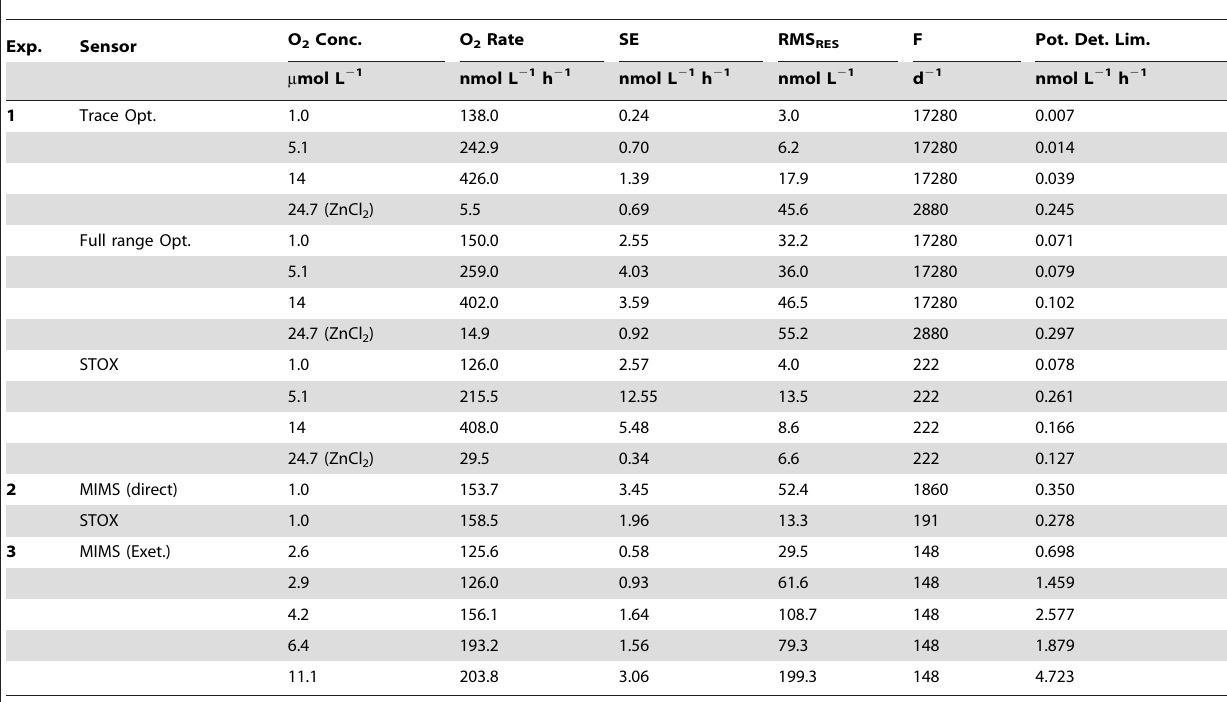
Table 1. Summary of measured O 2 consumption rates, method settings and statistics.